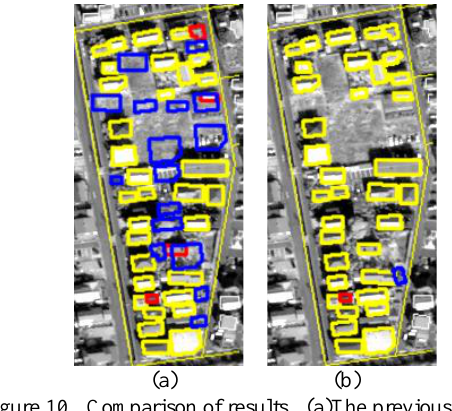
Figure 10. Comparison of results. (a)The previous method. (b)The proposed method. (yellow=existing, red=changed, blue=newly-built)